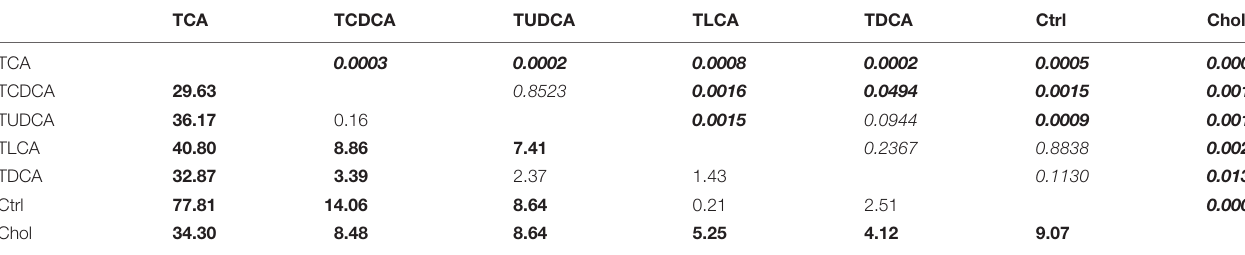
TABLE 1 | PERMANOVA analysis of biliary BAs with Bray–Curtis